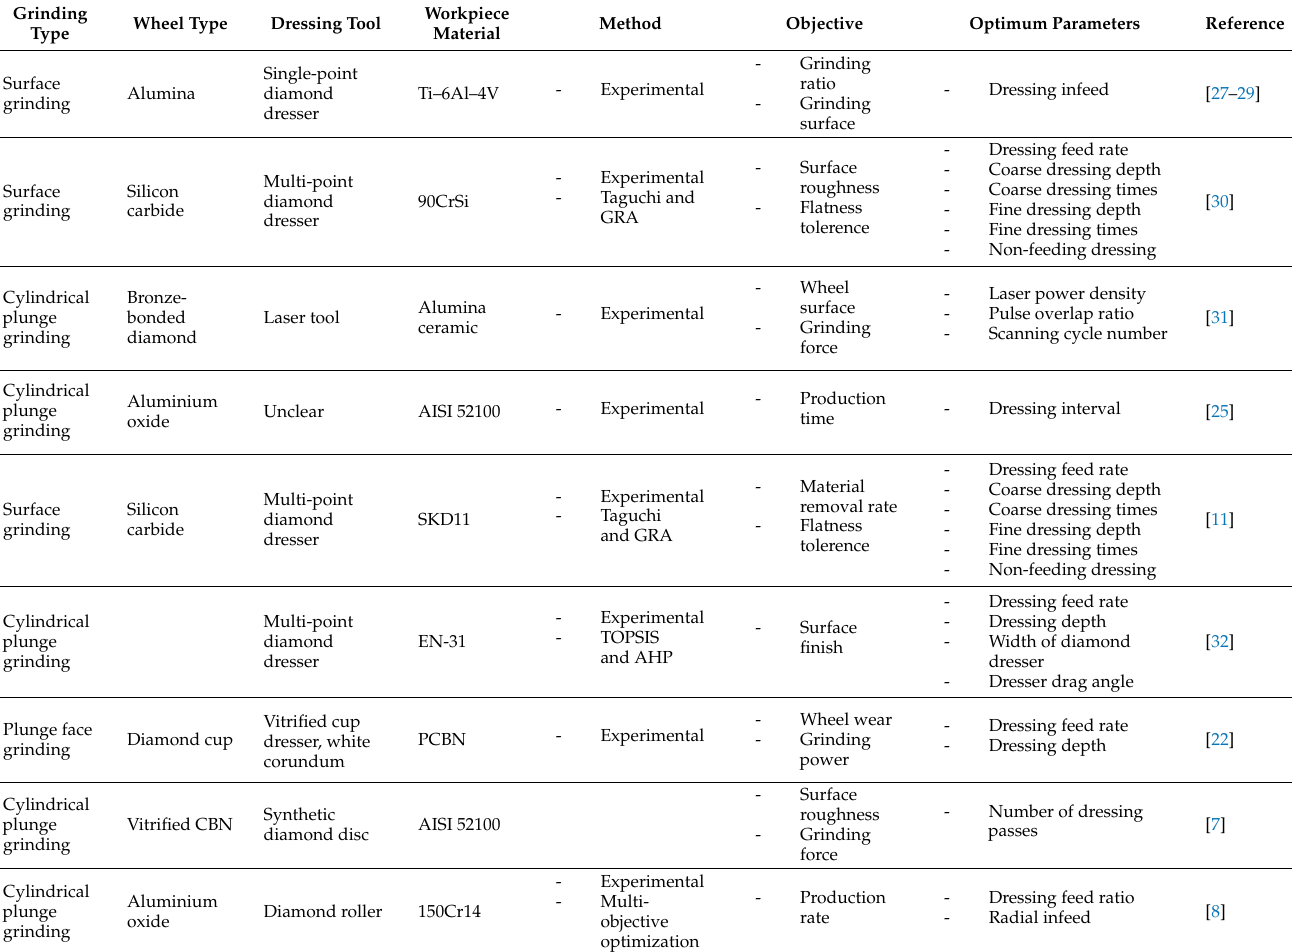
Table 1. Several previous research results on optimization of dressing